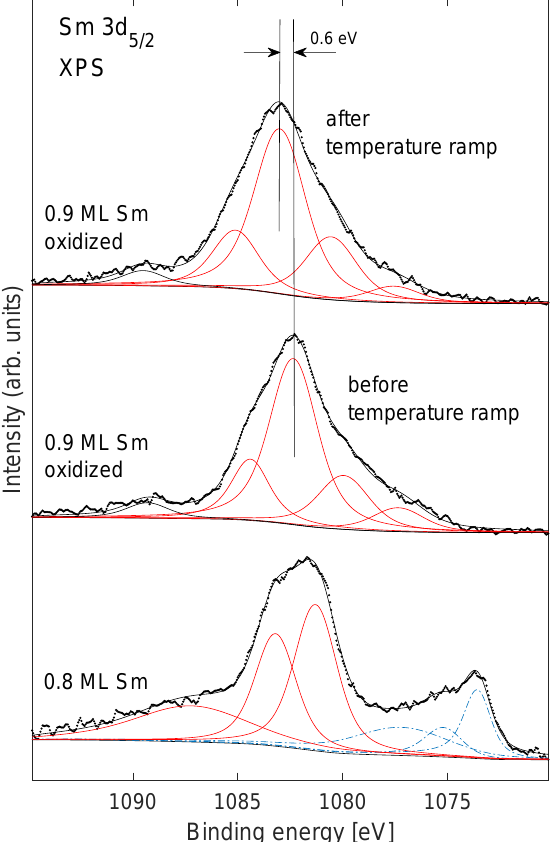
Figure 4. Sm 3 d 5/2 XPS for Sm/Ni ( bottom spectrum ), oxidized sample before temperature ramp ( middle spectrum ), and oxidized sample after temperature ramp ( top spectrum ). Effective Sm coverage as indicated in the figure. Solid lines show convolution of Sm 3 + components, and dashed lines show the Sm 2 + components. Table 1. XPS intensities I Sm / I Ni and I O / I Ni of Sm 3d and O 1s relative to Ni 2p core levels for samples of effective Sm coverage of 0.4, 0.9, and 1.9 ML, and oxygen dose of 10 L. The intensities were corrected for atomic sensitivity factors. The label 1st run indicates measurements recorded before temperature ramp to 900 K, and 2nd run indicates measurements recorded after temperature ramp. ∆ Ni and ∆ O show percentage change in relative intensities I Sm / I Ni and I O / I Ni after the temperature ramp. Sample I Sm / I Ni I O / I